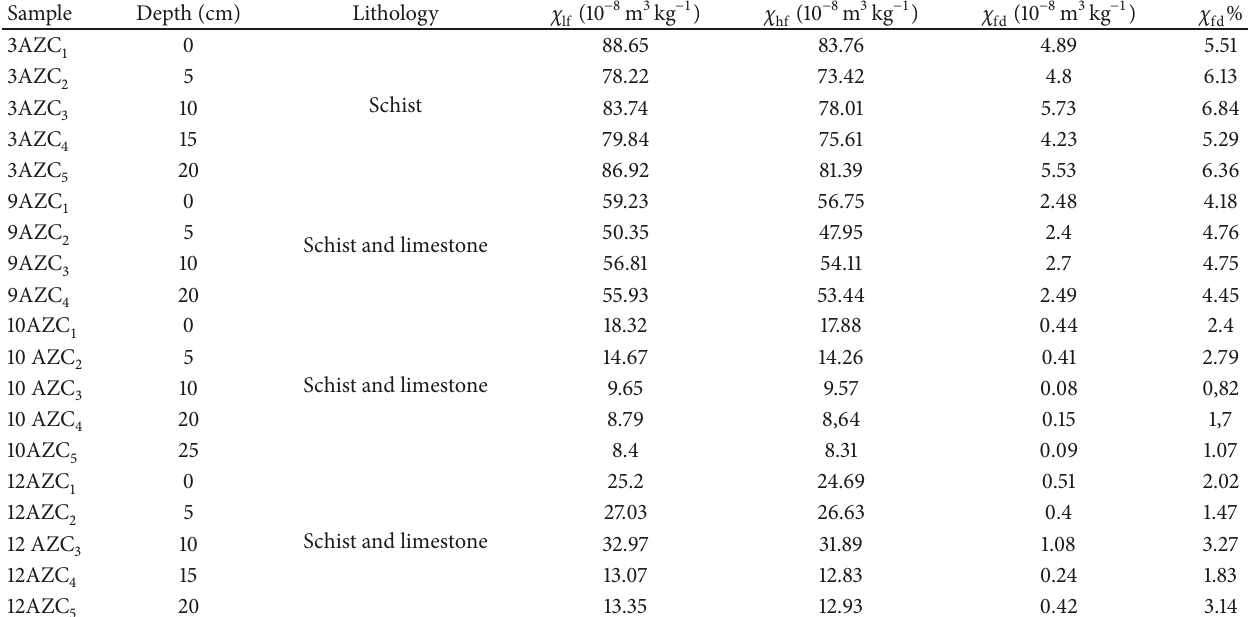
Table 3: Magnetic parameters measured on the different samples of Ait Azzouz cultivated land.